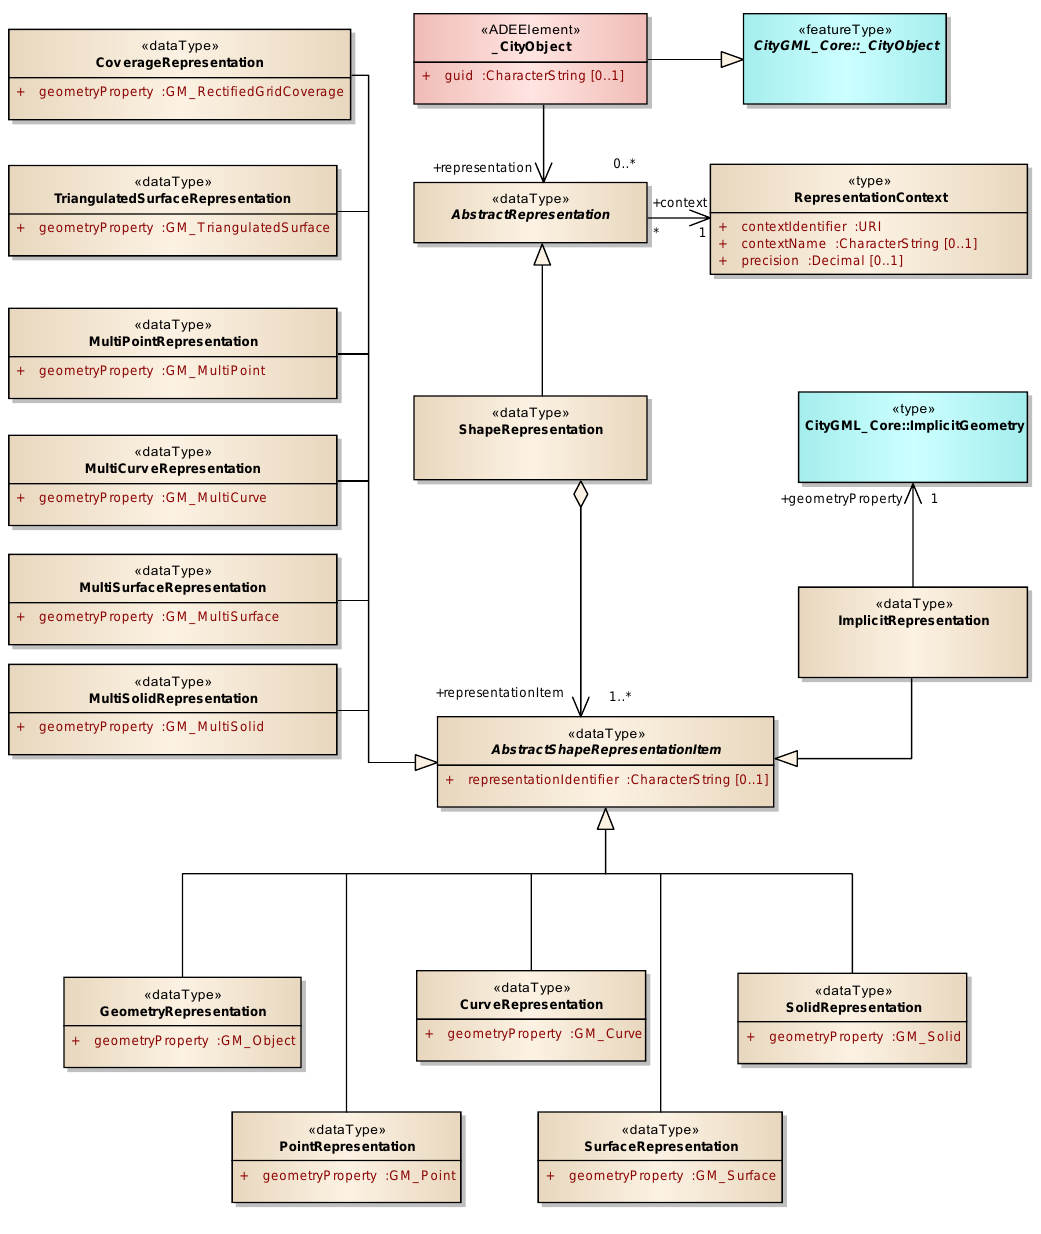
Figure 1 comprising all types used in CityGML 2.0.